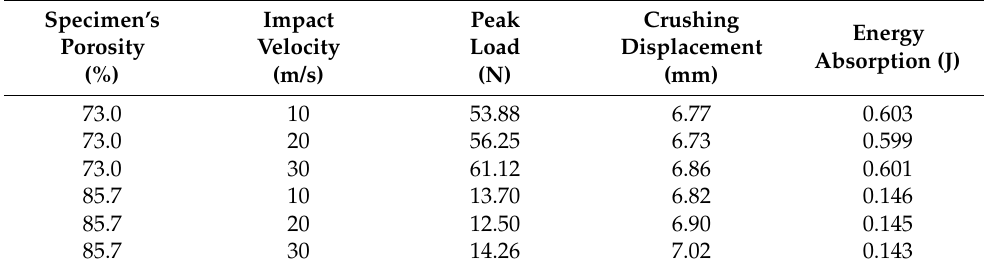
Table 2. Impact properties of closed-cell Al foam